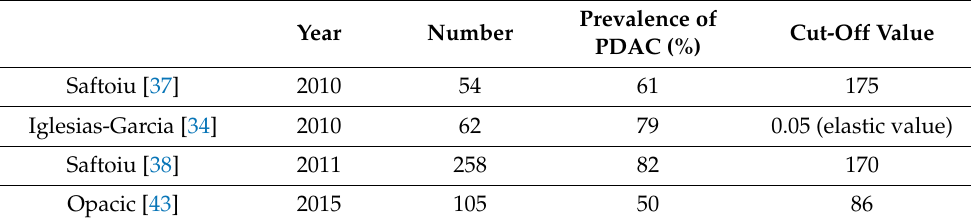
Figure 3. Endosonography(EUS) elastography in pancreatic ductal carcinoma. Table 2. Usefulness of histogram in pancreatic solid